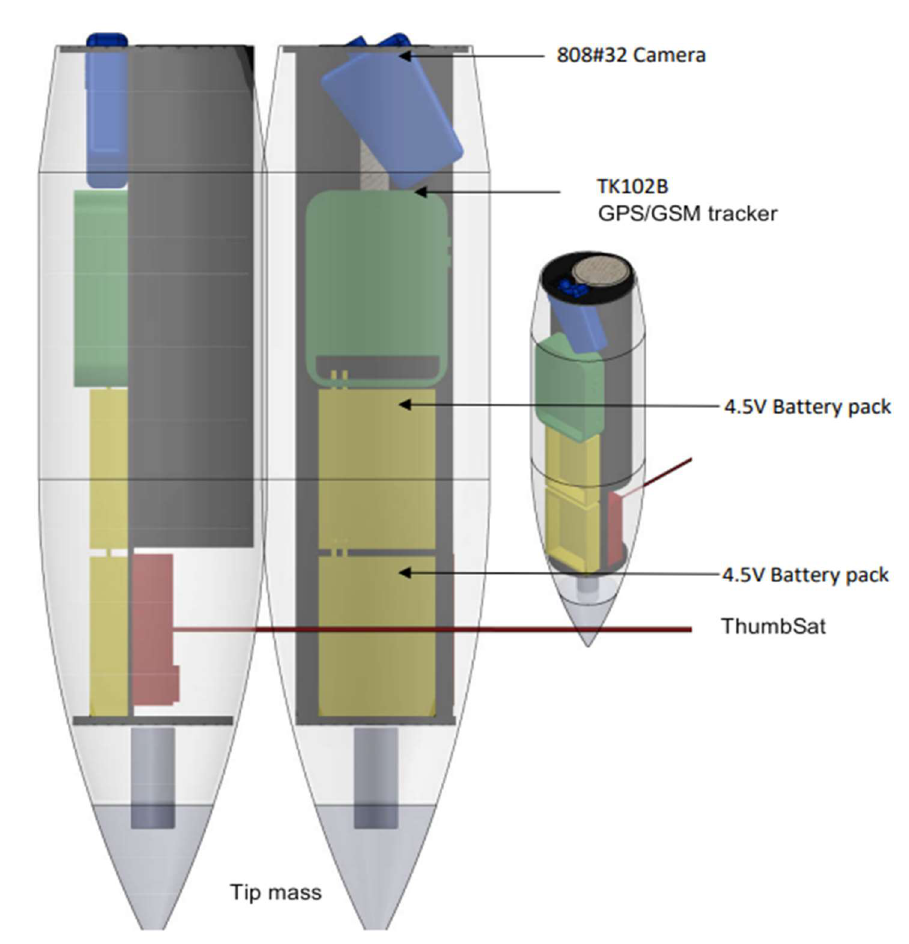
Figure 6. Payload schematic.